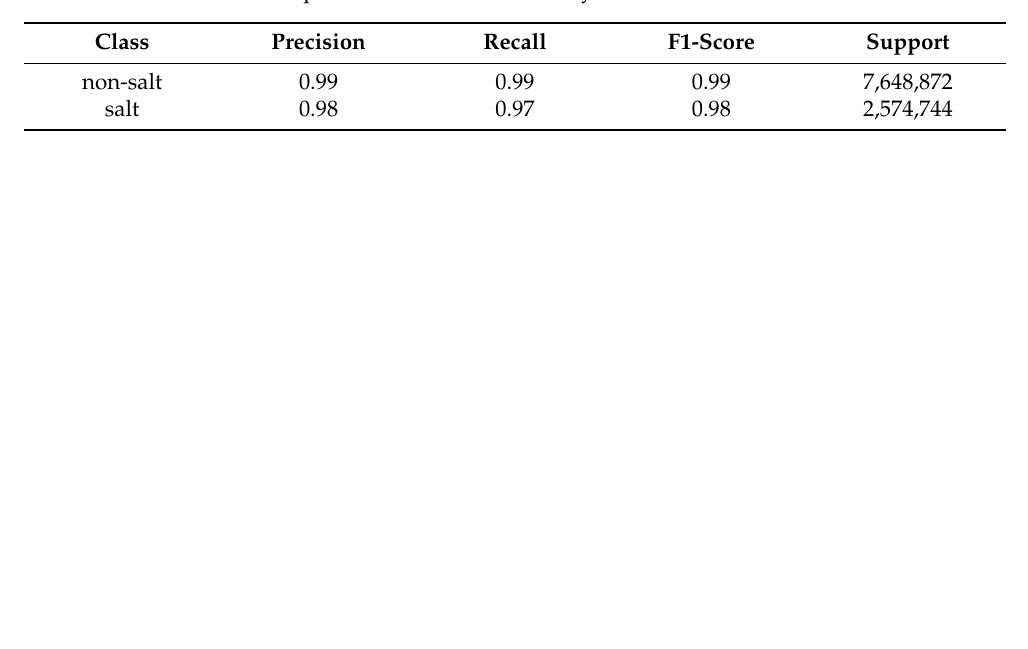
Table 5. The classification report for validation data on synthetic seismic